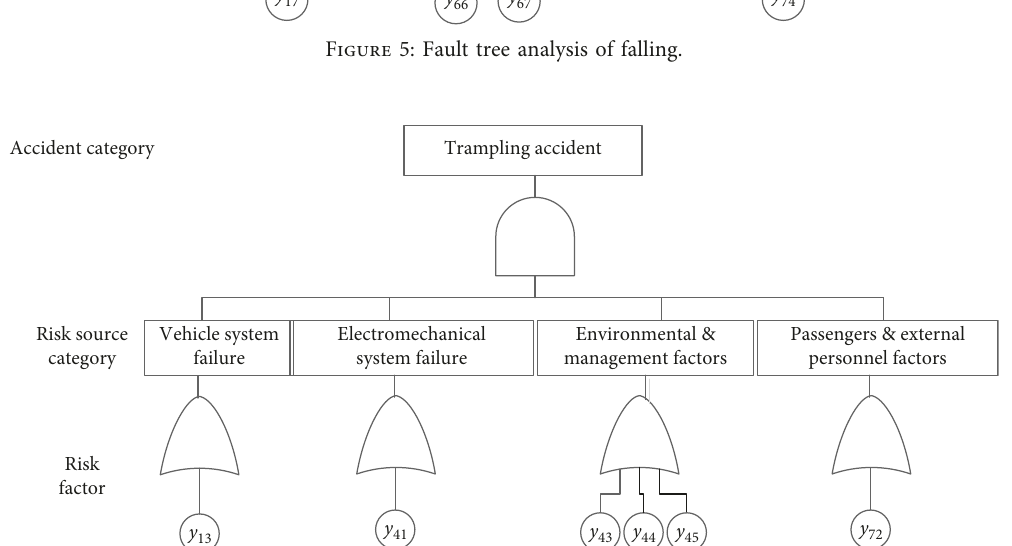
Figure 5: Fault tree analysis of falling.